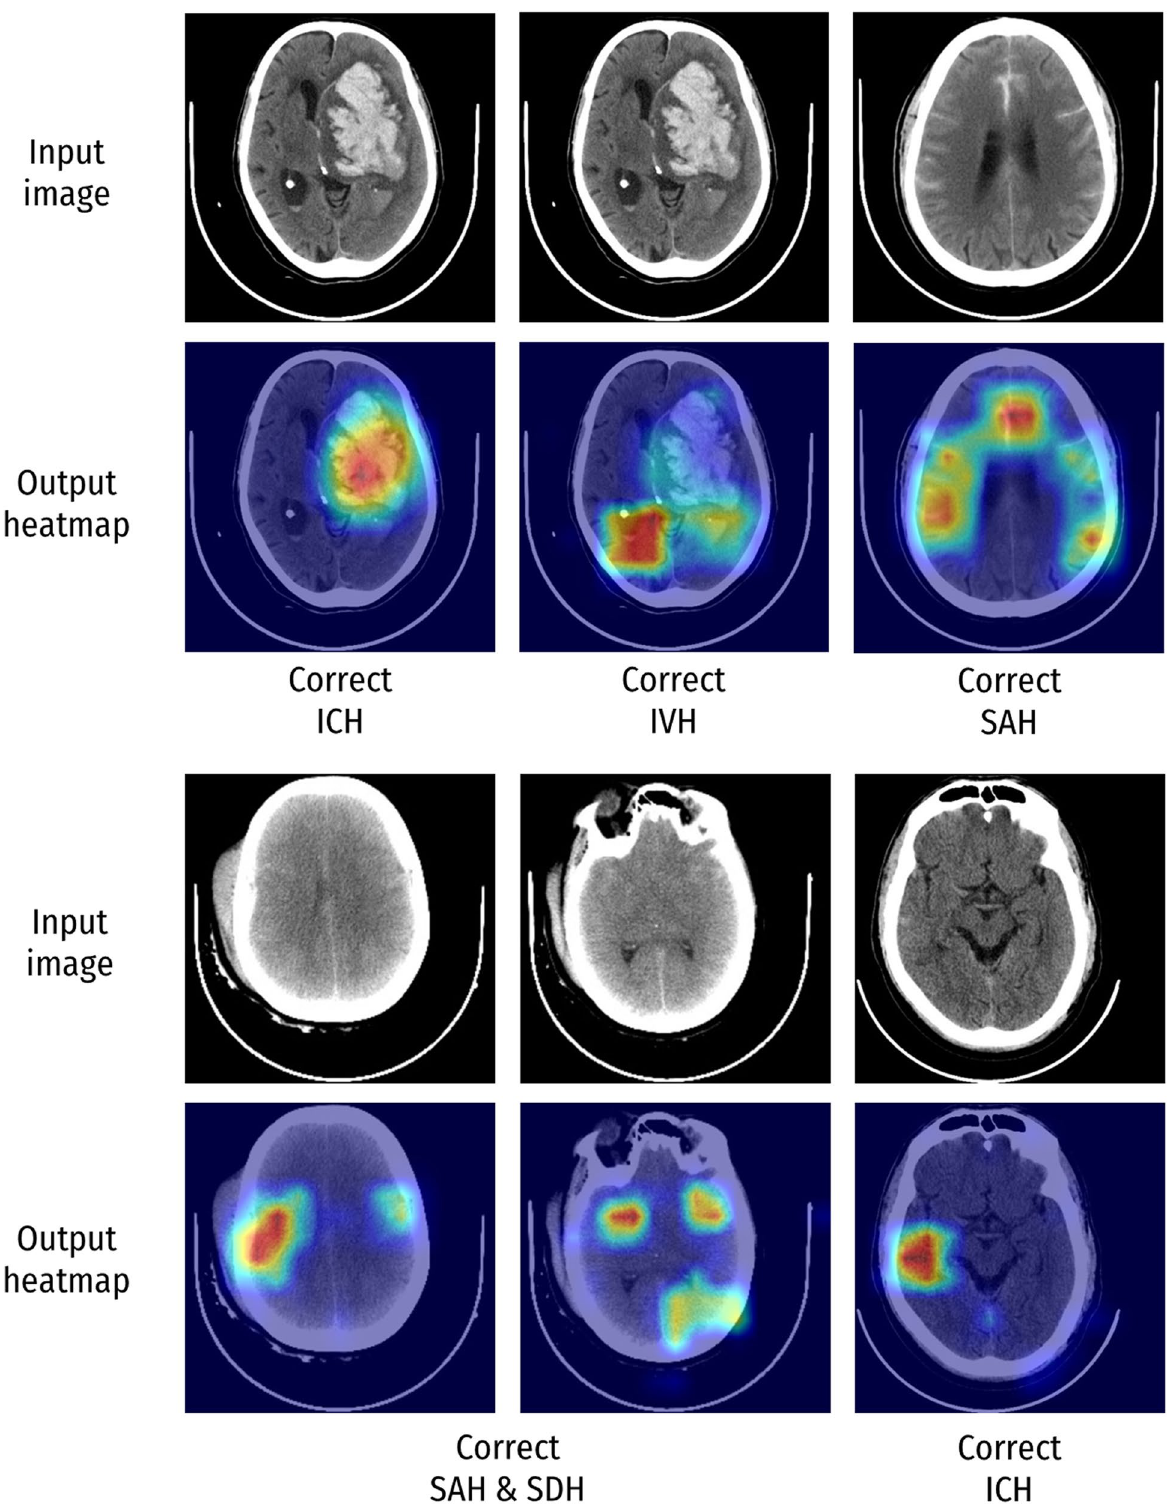
Fig. 3 Visualisation of correct model predictions using heatmap images. Examples of the regions that contributed to the model decision in predicting the presence of haemorrhages. The warmer the colour (red > orange > yellow > green > blue), the greater the contribution of the image pixel to the prediction. EDH Extradural haemorrhage, ICH Intracerebral haemorrhage, IVH Intraventricular haemorrhage, SDH Subdural